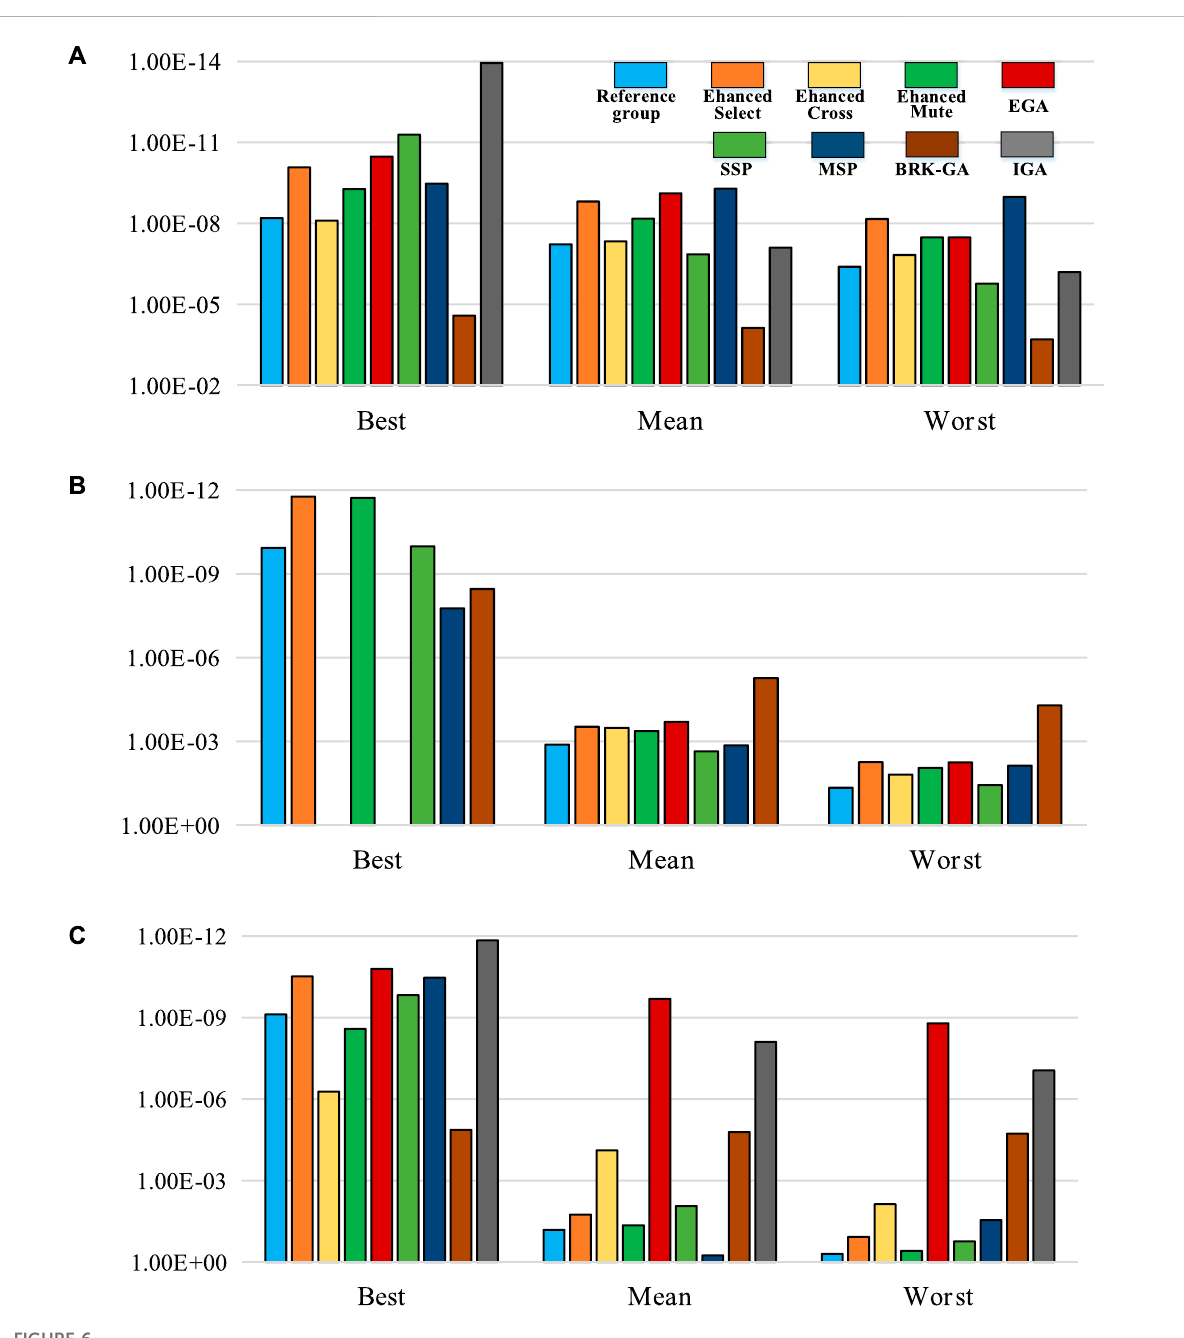
FIGURE 6 Comparisonoftheninedesignedexperimentsonthebasisoftheirbest,mean,andworst fi tnessvaluesforthesixtestfunctions(1): (A) funtion1, (B) funtion2 and (C)